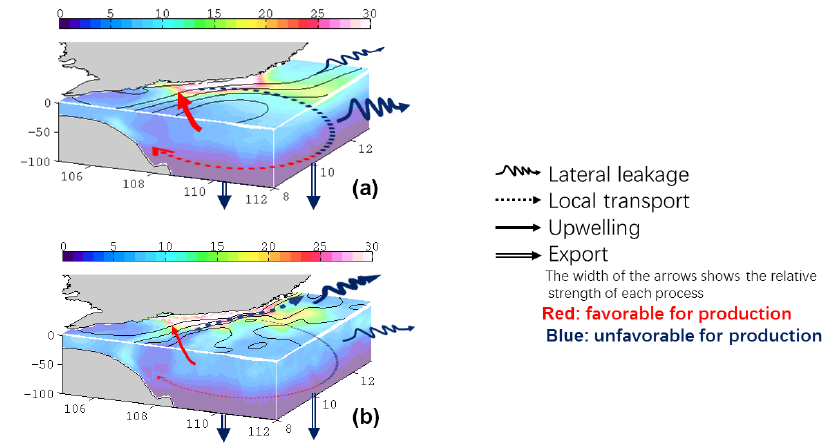
Figure 12. Schematic diagram summarizing the dynamics in different scenarios of distinct circulation pattern in the VBUS, overlapped with the three-dimensional distribution of PP (unit: mgCm − 3 day − 1 ). (a) Normal state: the separated jet transports the upwelled nutrients and produced organic matter offshore. While a substantial portion of the offshore transported organic matter leaks into the interior of SCS and never comes back, the recirculation and quasi-stationary anticyclonic eddy trap the organic matter locally and hinder further leakage of available nutrients in the VBUS. The locally recirculated nutrients are then upwelled in the bottom Ekman layer, rejoining the production process over the shelf. (b) Non-separation state: during the non-separated circulation, the along-isobath circulation transports the organic matter northward. The leakage of organic matter reduces the nutrient inventory in the VBUS. The loss of nutrients diminishes the nutrient inventory available for remineralization and upwelling, further inducing a reduction in the production